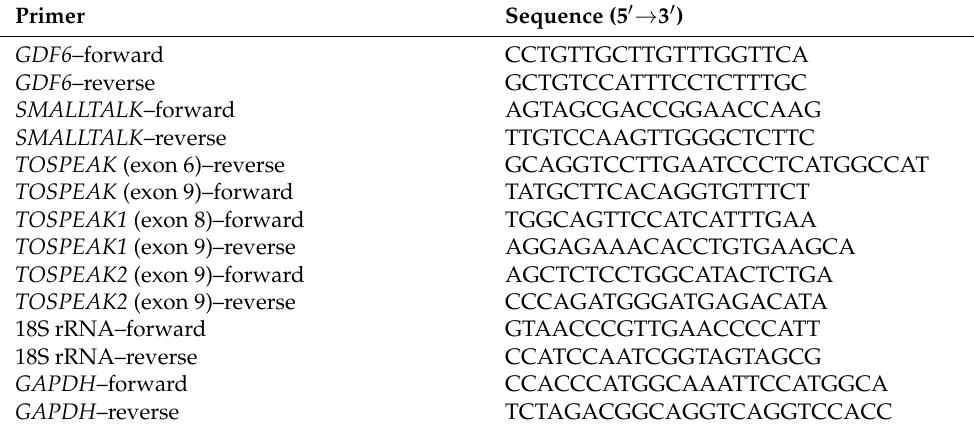
Table 1. Primer Table.